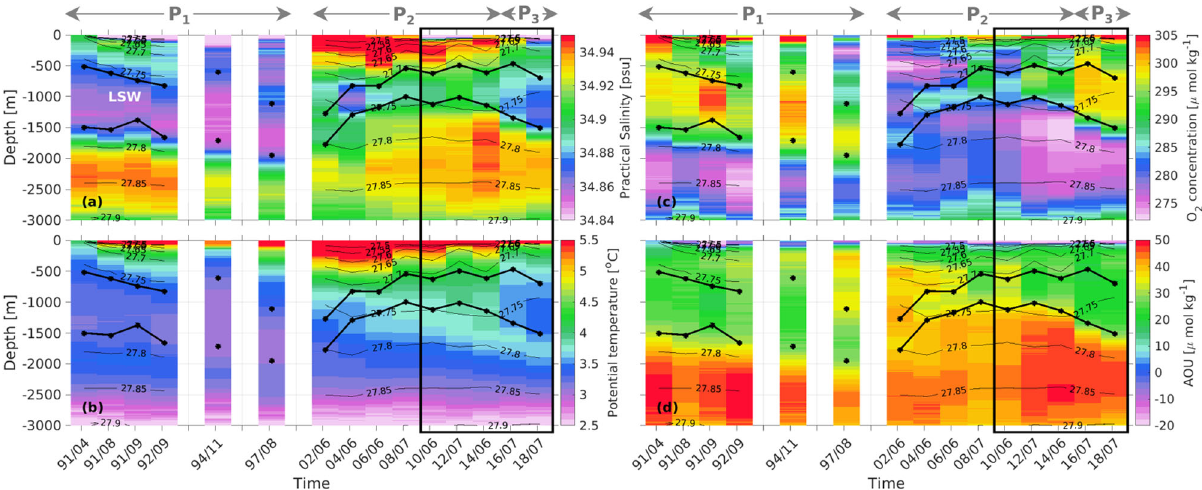
Fig. 3 Temporal variability of the water properties in the Irminger Sea from hydrographic sections. Variability between 1991 and 2018 of a practical salinity (psu), b potential temperature θ ( ∘ C), c oxygen concentration ( μ mol kg − 1 ), and d Apparent Oxygen Utilization AOU ( μ mol kg − 1 ) computed along the hydrographic sections (OVIDE, A01E, AR07E) within the Irminger Sea (longitudes between 40 ∘ W and 35 ∘ W). The black square denotes the period covered by Argo sampling as shown in Fig. 3, and the black solid lines with dots highlight the upper and lower boundaries of the Labrador Sea Water (LSW) layer. Note that the x -axis is not evenly spaced, and that the longest gaps are marked with a blank space. The three periods (P 1 , P 2 , and P 3 ) discussed throughout the manuscript are indicated with arrows on top of the fi